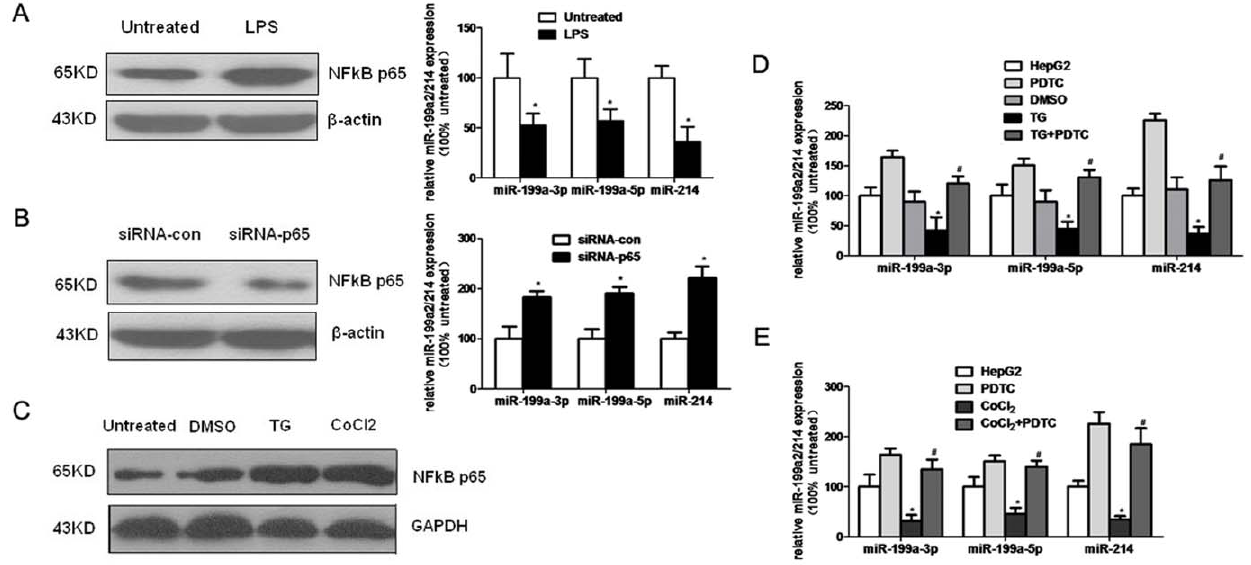
Figure 6. The regulatory role of NF k B in miR-199a/214 Expression. ( A ) LPS (10 m g/ml) treatment induced NFkB p65 expression, attenuates the miR-199a/214 expression in SMMC-7721 cells. ( B ) siRNA specifically targeting human NF-kB P65 subunit (100 nM) dereased NFkB p65 expresssion and increased the expression of miR-199a/214 in SMMC-7721 cells. ( C ) NF- k B is activated by ER Stress and hypoxia in HepG2 cells analyzed by Western blotting. ( D, E ) miR-199a/214 expression in HepG2 cells treated with ER stress inducer (5 m mol/L TG and 100 m M CoCl 2 ) and NF k B inhibitors PDTC (100 m M). *P , 0.05 vs untreated (HepG2 or SMMC-7721) or DMSO or siRNA con-treated; # P , 0.05 vs TG or CoCl 2 treatment.